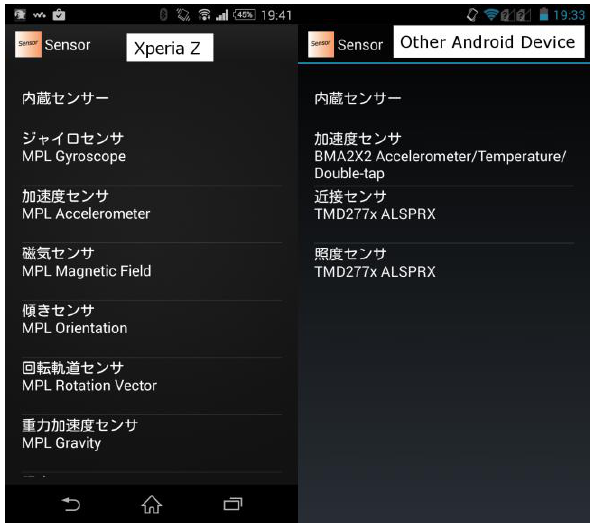
Figure 2. Difference of mounted sensor